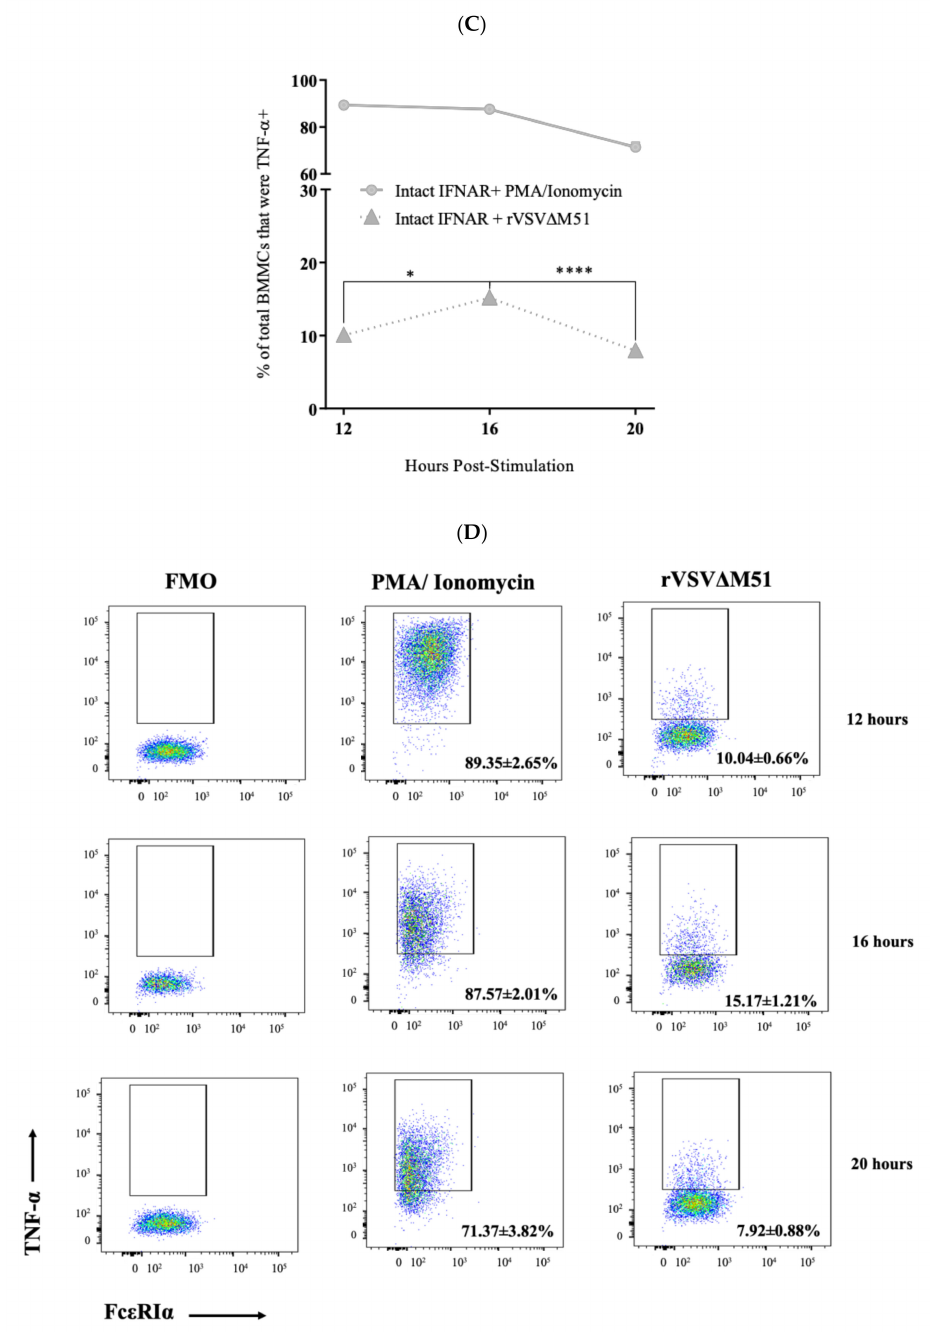
Figure 2. Kinetics of cytokine production by murine bone-marrow-derived mast cells (BMMCs) after infection with a recombinant strain of vesicular stomatitis virus (rVSV ∆ m51). BMMCs were infected with rVSV ∆ m51 at a multiplicity of infection of 10. At 12, 16, and 20 h post-infection, the cells were stained for the surface markers Fc ε RI α and c-kit, as well as intracellular cytokines interleukin (IL)-6 and tumor necrosis factor (TNF)- α . The cells were then analyzed using flow cytometry. Fluorescence minus one (FMA) controls were used to set gates to identify IL-6 + and TNF- α + cells. Phorbol 12-myristate 13-acetate (PMA) and ionomycin were used as a positive control stimulus. Graphs and representative dot plots show means and standard deviations pooled from four experimental replicates of ( A , B ) IL-6 + and ( C , D ) TNF- α + Fc ε RI α + c-Kit + mast cells at 12, 16, and 20 h post-infection. Two-way analysis of variance with Tukey’s multiple comparison test was used to define statistical significance as * p < 0.05; ** p < 0.001; **** p <